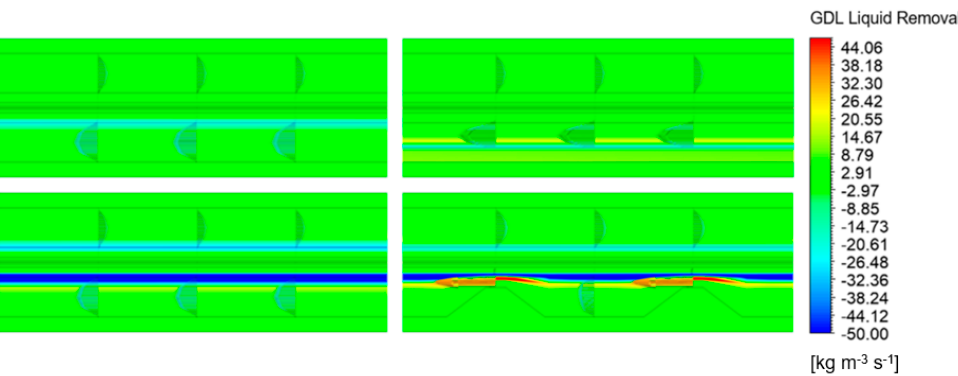
Figure 4. GDL liquid removal rate contours: conventional rectangular channels ( above left ); biporous cathode channel ( above right ); porous cathode channel ( below left ); porous and baffled cathode channel ( below right ) at operating current density of 4.0 A·cm − 2 .